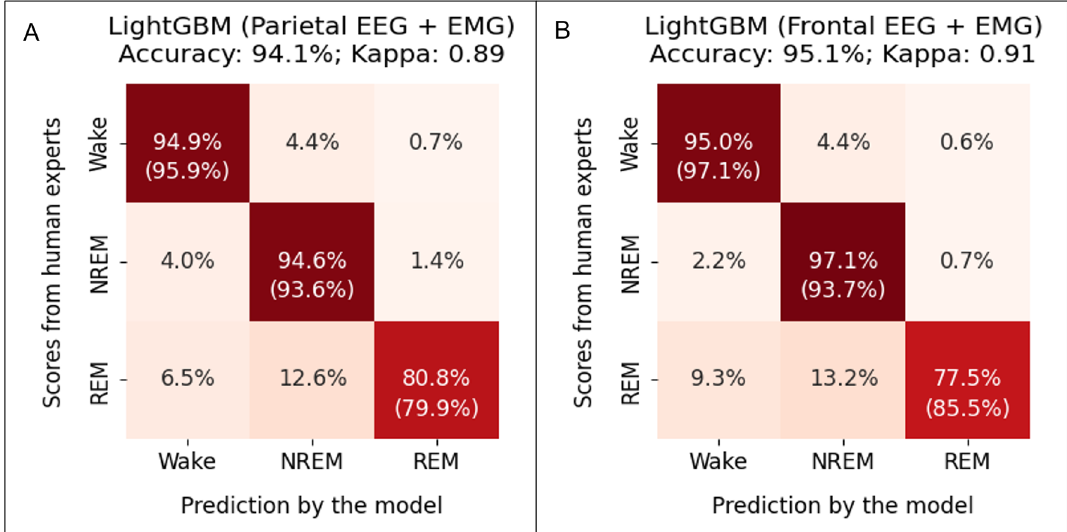
Figure 7. The performance of the LightGBM-1EEG model in the test data containing one EMG channel and one EEG channel in the parietal region ( A ) or in the frontal region ( B ). The numbers without parentheses in the heatmaps indicate the percentage of the scores from human experts (ground truth) that are in agreement with the scores generated by the model. The numbers inside parentheses indicate the percentage of model-generated scores that are in agreement with the scores of the human experts. Therefore, in the left–right diagonal line, the numbers without parentheses indicate recall, and the numbers inside parentheses indicate